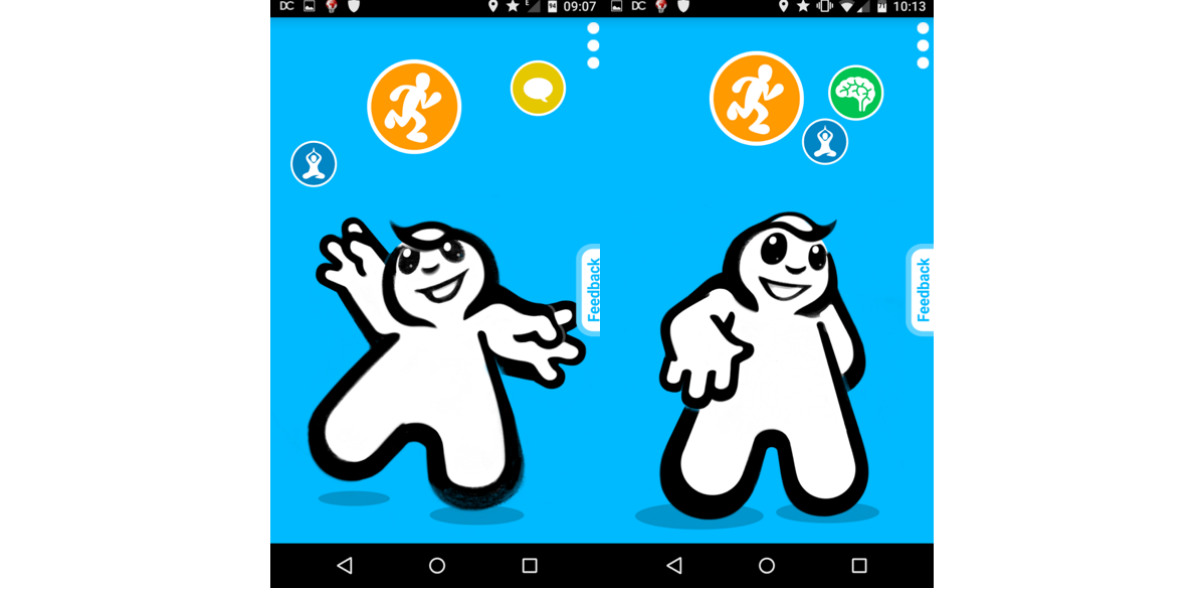
Figure 4 for an example of interventions of a chosen basket presented to the user.